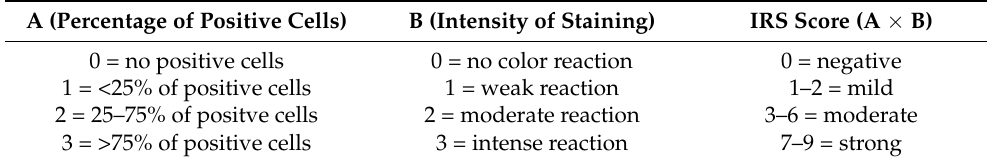
Table 3. The immunoreactive score